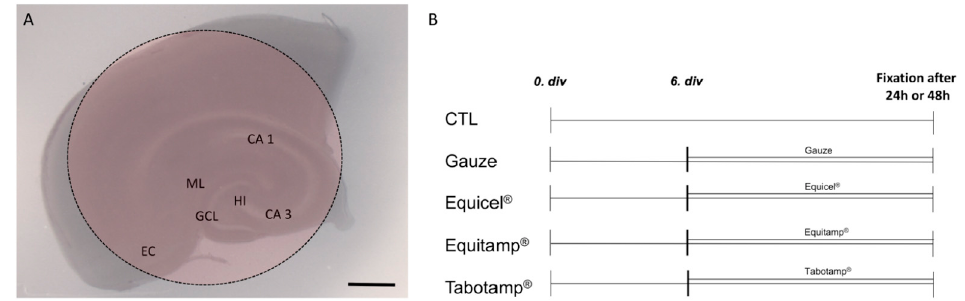
Figure 6. Schematic representation of an OHSC with ORC and treatment protocol. Schematic visualization of OHSC in culture. Intact cytoarchitecture of the OHSC is demonstrated with the entorhinal cortex (EC), the hippocampus with cornu ammonis (CA) subfields CA 1 and CA 3, the hilus region (HI) and the dentate gyrus with the molecular layer (ML) and the granule cell layer (GCL). The red area indicates the location of the ORC ( A ). Treatment protocol of the OHSC ( B ). Bar = 1 mm.